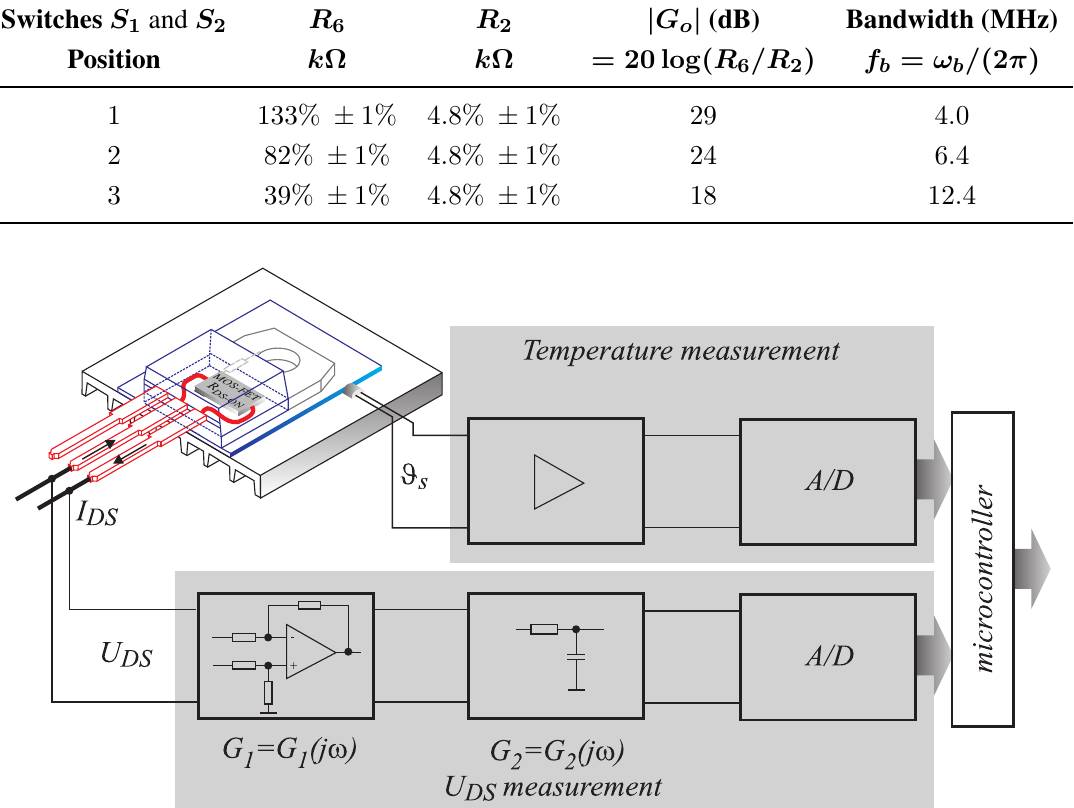
measurement chains. s